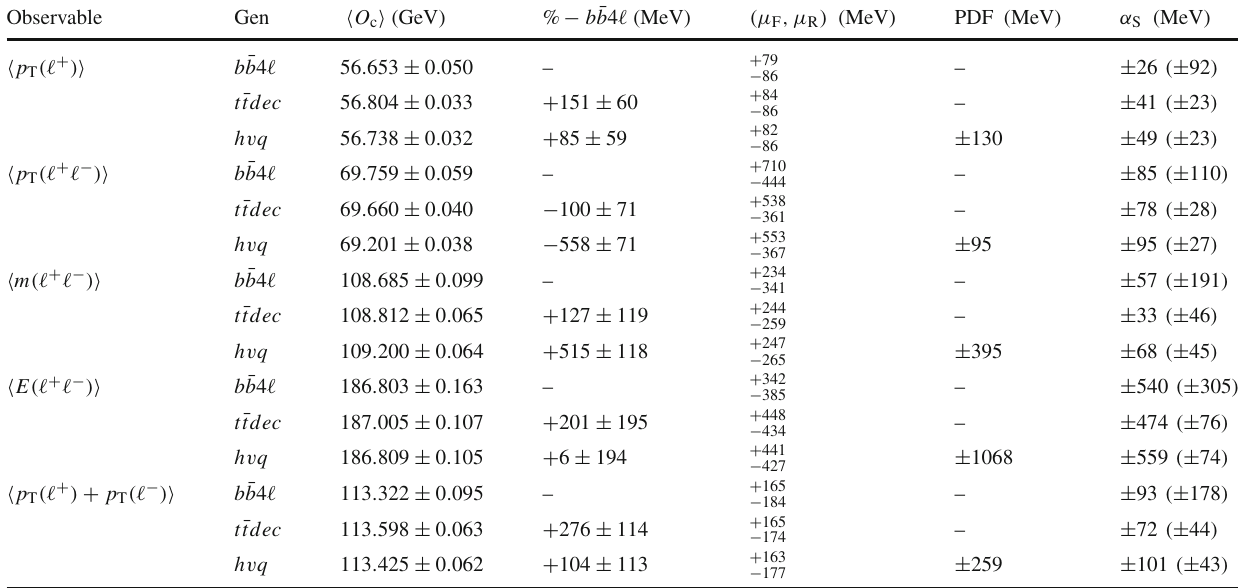
Table 19 The average values of each leptonic observable com- puted with b ¯ b 4 (cid:4) , t ¯ tdec and h v q , showered with Pythia8.2 , for m t =172.5 GeV, and their variations with respect to b ¯ b 4 (cid:4) are shown in the first two columns. The differences with respect to their correspond- ing central values due to scale and PDF variations are also shown in